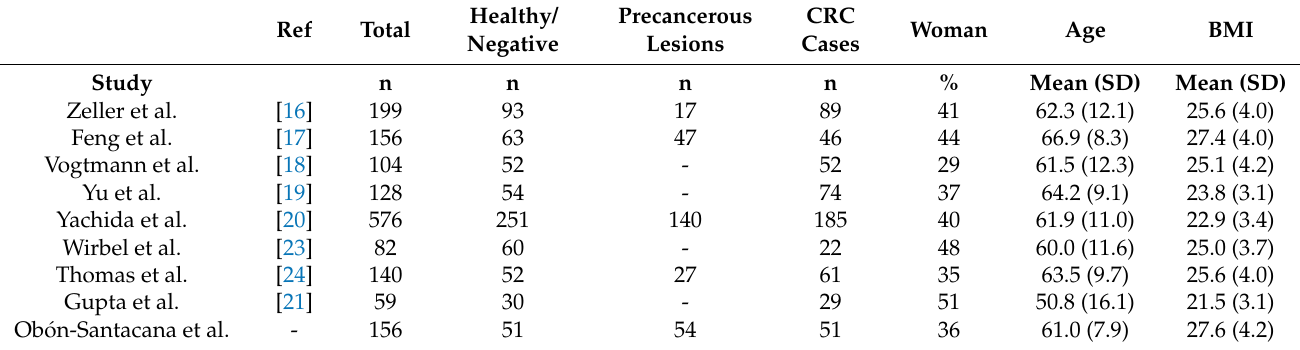
Table 1. Summary of sample sizes and epidemiological data of all the included